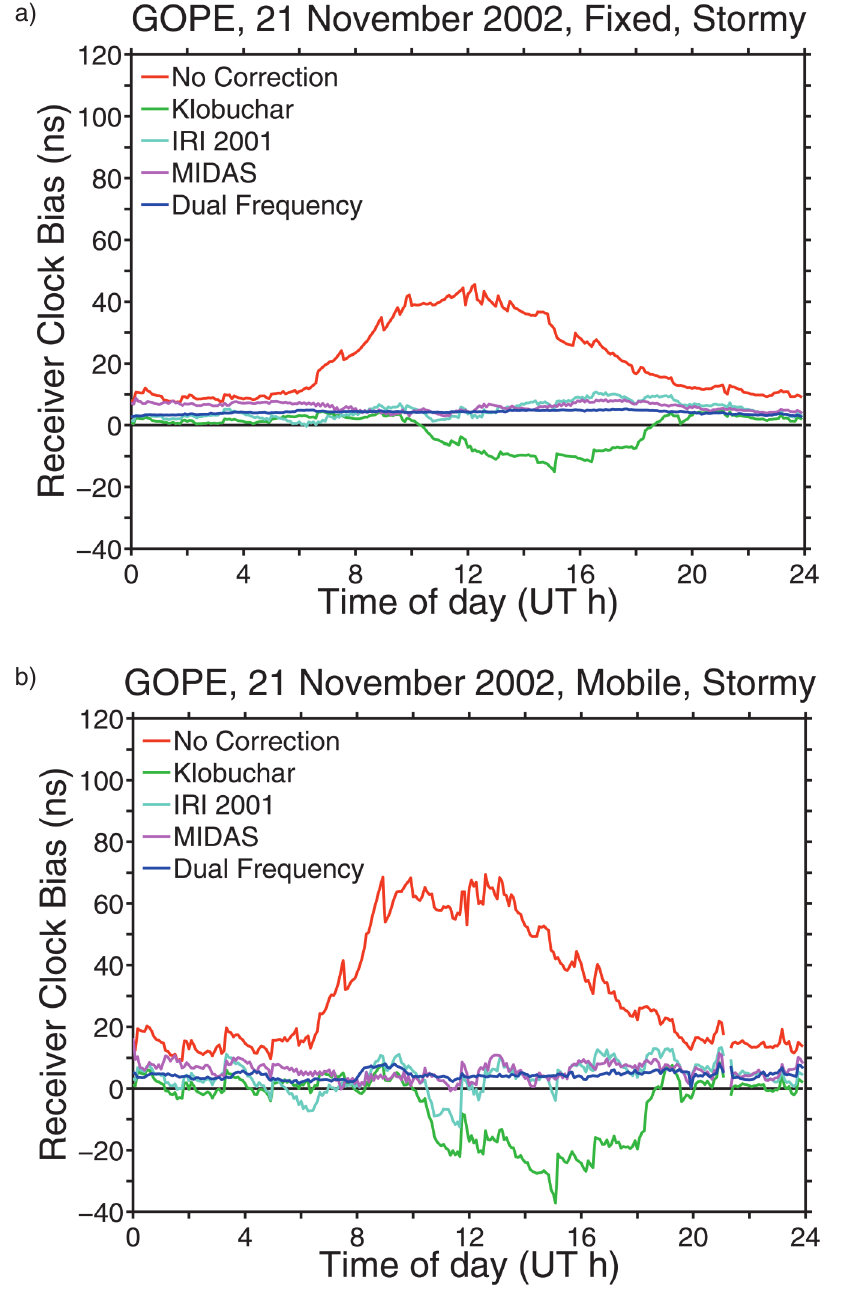
Fig. 3a,b. Receiver clock bias referenced to the receiver clock bias from CODE for GOPE 21 November 2002, for a stormy ionosphere (Kp index 4.3-6.7) using a fixed (a) and mobile (b) GPS receiver